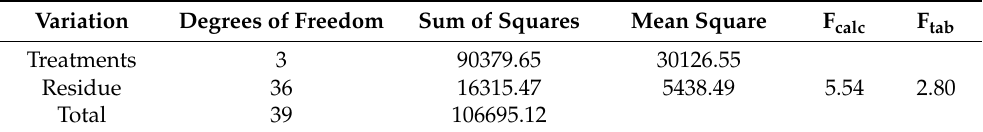
Table 2. Analysis of variance for the tensile strength of the caranan fiber-reinforced composites. Variation Degrees of Freedom Sum of Squares Mean Treatments